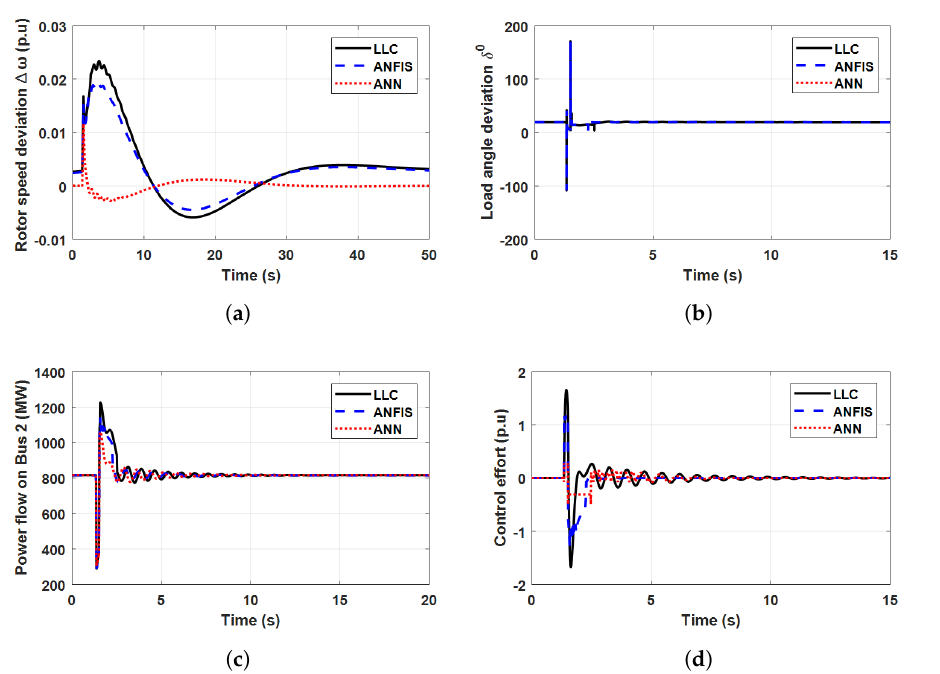
Figure 12. Case 4: Impact 3-phase fault upon the two-area power system. ( a ) Rotor speed deviation. ( b ) Load angle deviation. ( c ) Flow of power through the line 2. ( d ) control